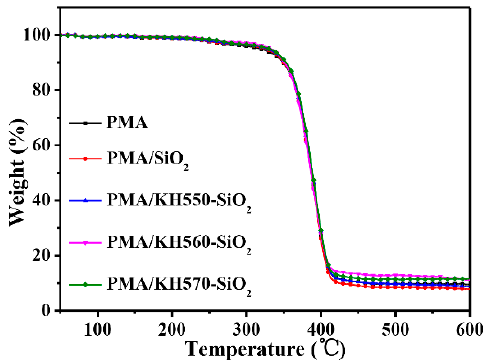
Figure 13. TGA curve of composite films.